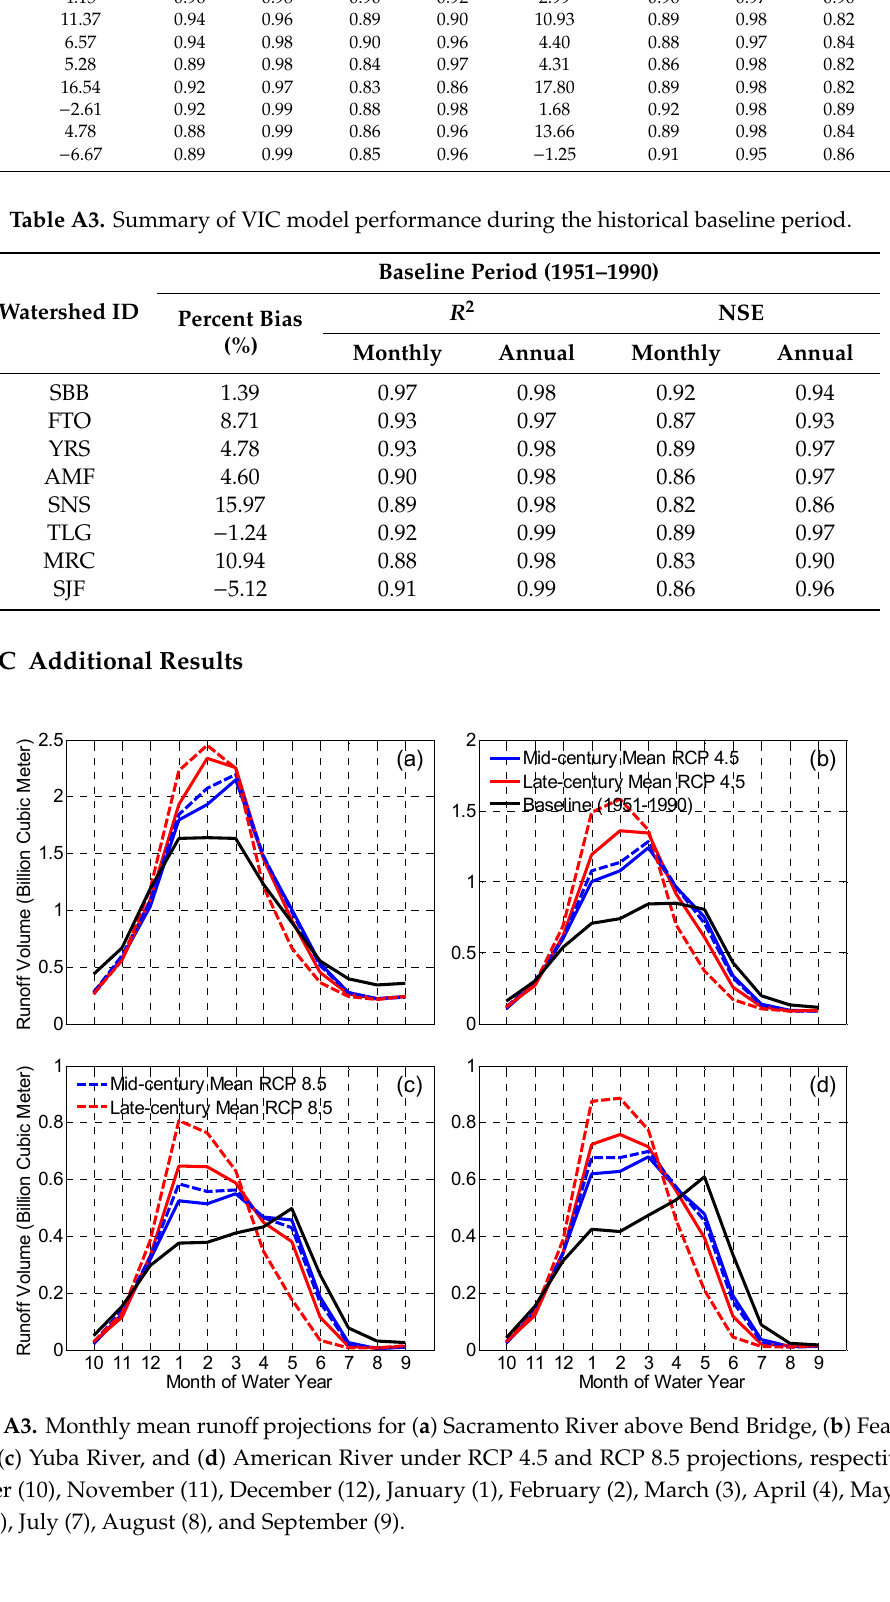
Figure A4. Monthly mean runoff projections for ( a ) Stanislaus River, ( b ) Tuolumne River, ( c ) Merced River, and ( d ) San Joaquin River under RCP 4.5 and RCP 8.5 projections, respectively.